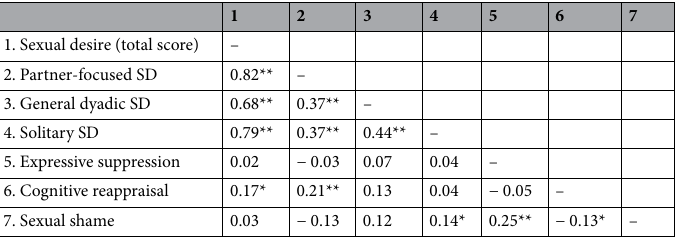
Table 2. Univariate correlations between the SDI-2, ERQ-10, and SSI-R. ** p < 0.01; * p < 0.05.